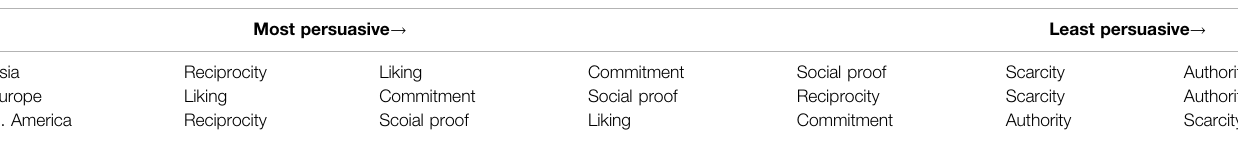
TABLE 6 | Persuasion pro fi les based on culture